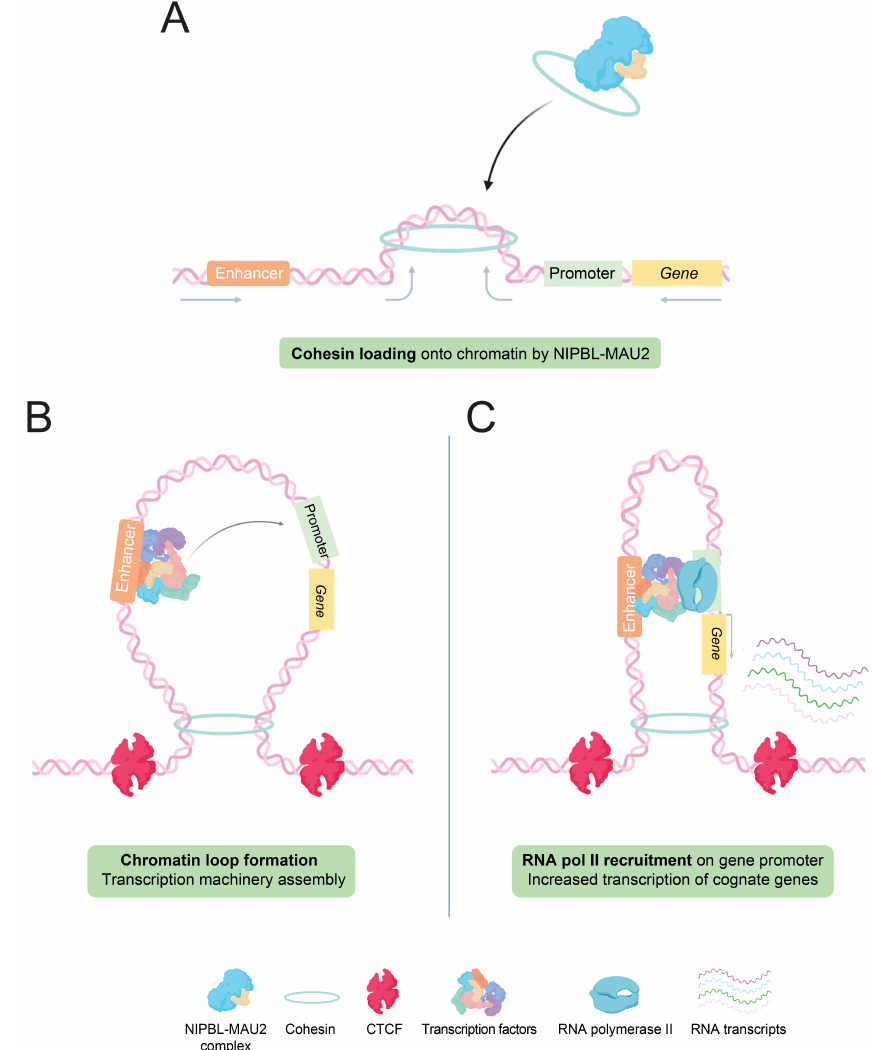
Figure 2. Loop extrusion model: Enhancer-promoter interactions through chromatin loops formation. ( A ) Cohesin rings are loaded onto chromatin by the NIPBL-MAU2 protein complex, at the base